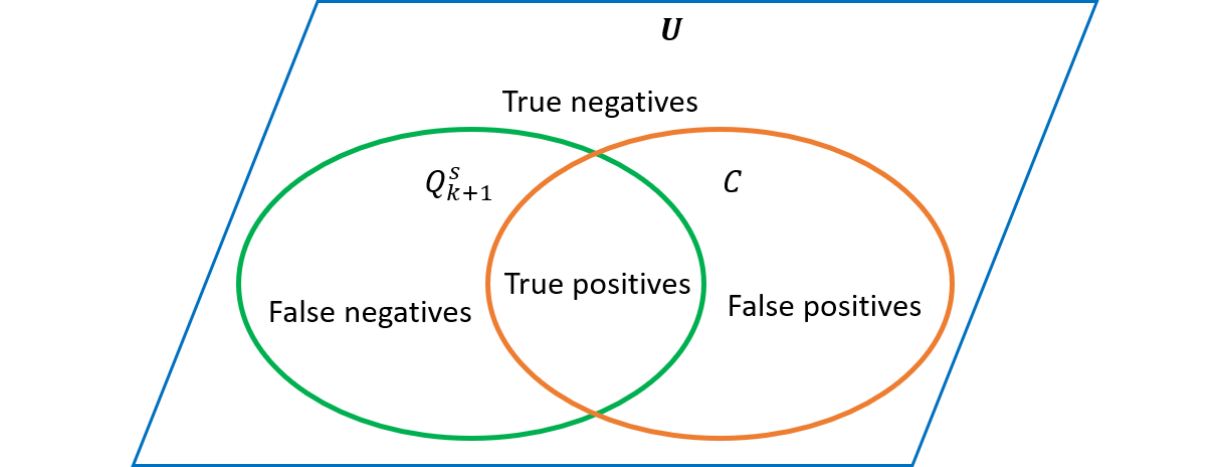
Figure 3. The connection between the ground truth concepts and the predicted concept